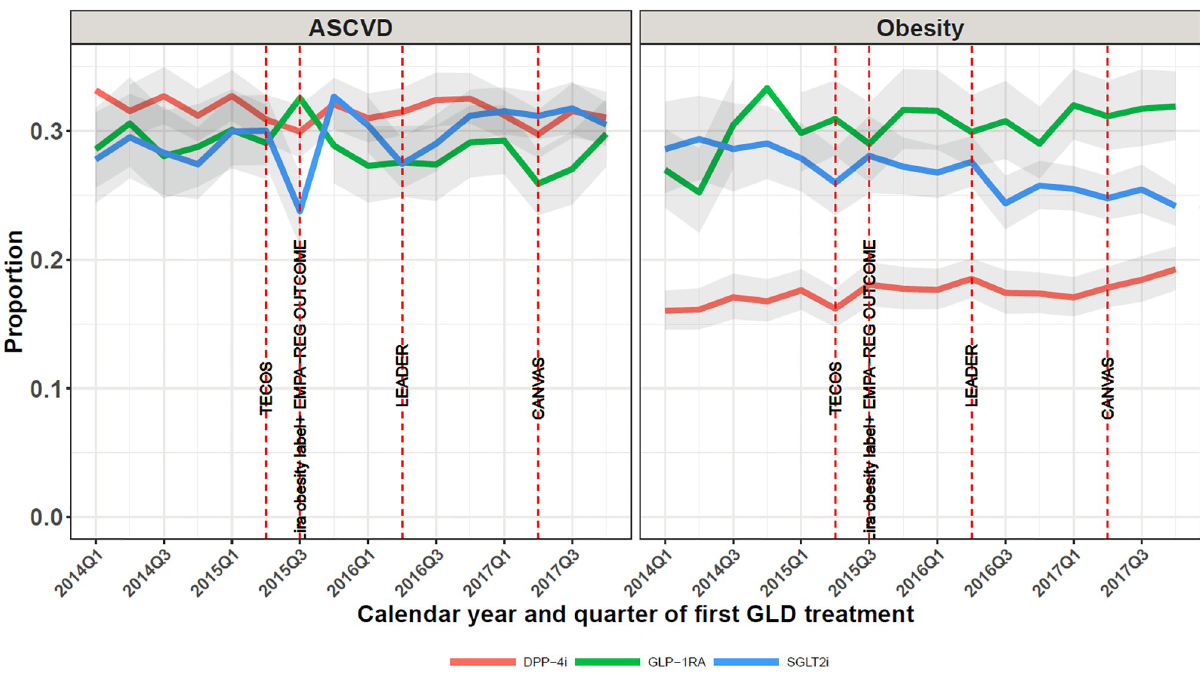
Fig 3. Time trends in proportions with established atherosclerotic cardiovascular disease (ASCVD) or hospital-diagnosed obesity at baseline. Obesity: used hospital inpatient and outpatient contacts. ASCVD: atherosclerotic cardiovascular disease; DPP-4i: dipeptidyl peptidase-4 inhibitor; GLP- 1RA: glucagon-like peptide-1 receptor agonists; SGLT2i: sodium-glucose cotransporter 2 inhibitors; TECOS: Sitagliptin (DPP-4i) showed non- inferiority to placebo [35]; Lira obesity label: Liraglutide 3 mg launched as treatment for obesity; EMPA-REG OUTCOME: empagliflozin showed CV and CV/all-cause mortality benefits [10], LEADER: liraglutide showed CV and CV/all-cause mortality benefits [12]; CANVAS: canagliflozin showed CV benefits [11].